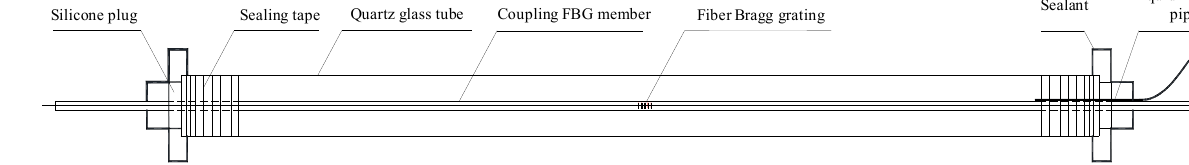
Fig. 2 Schematic diagram of the test heating